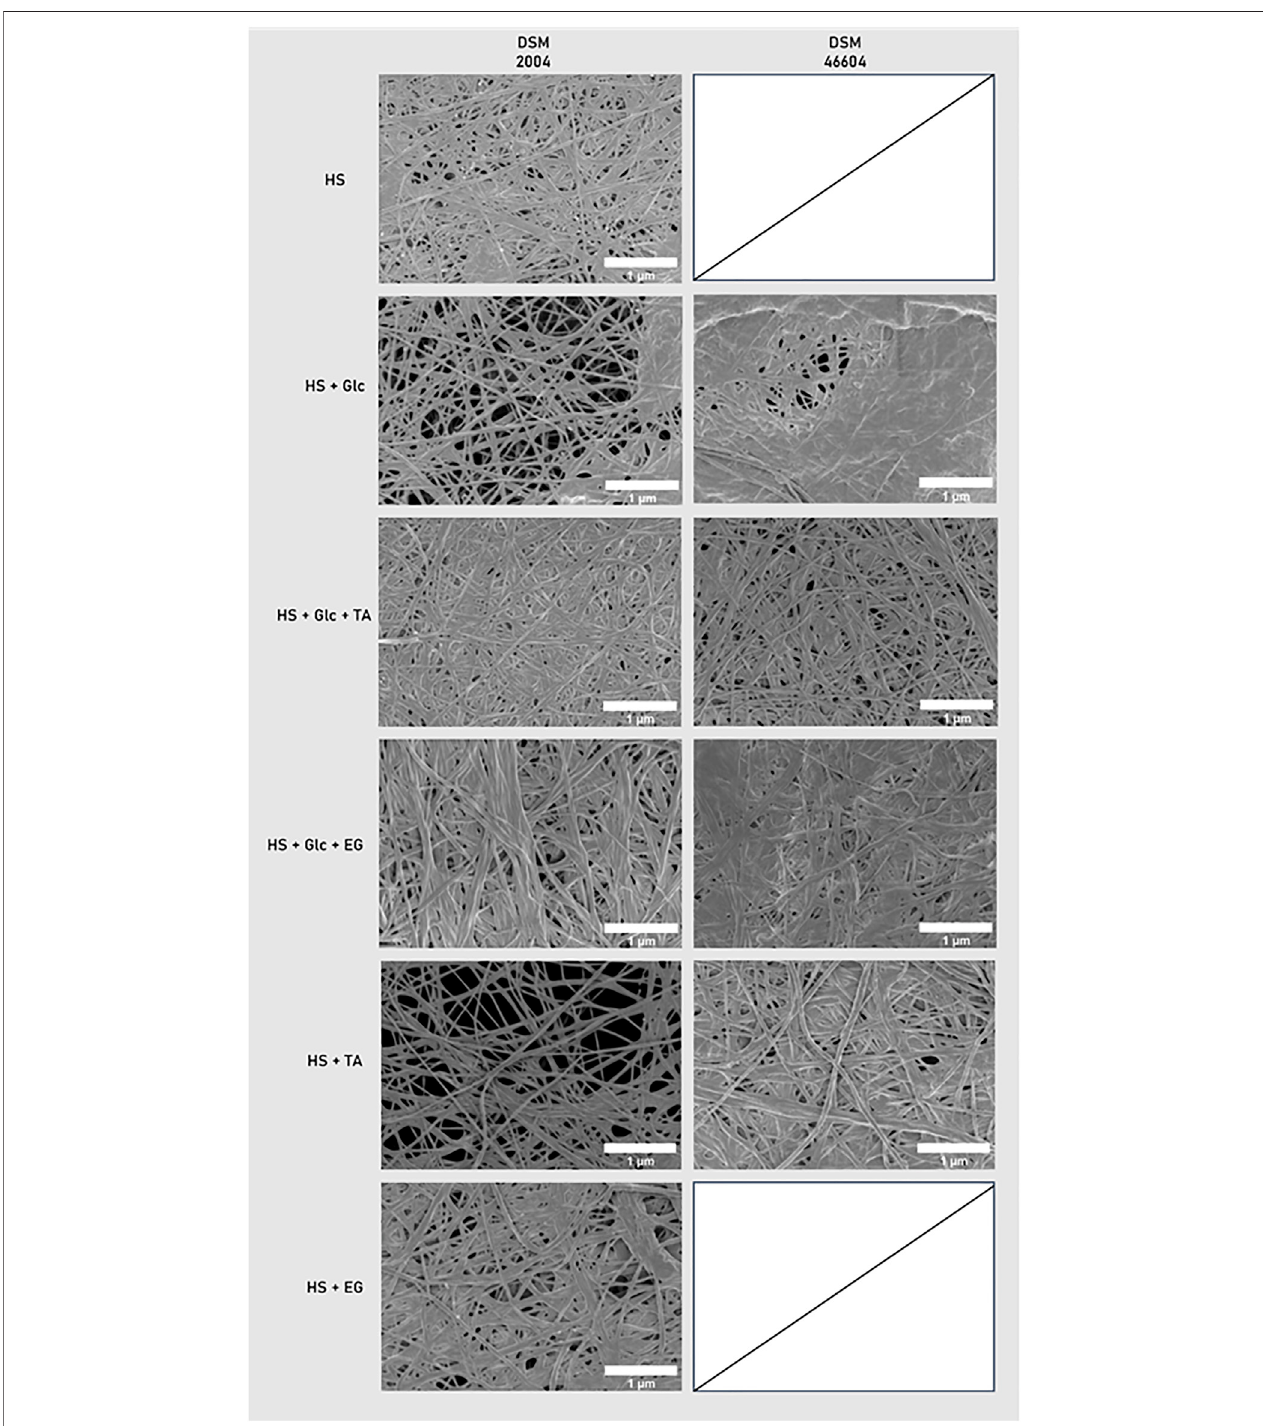
FIGURE 3 | SEM images of BC grown in glucose, TA, and EG by K. xylinus DSM 2004 and DSM 46604.